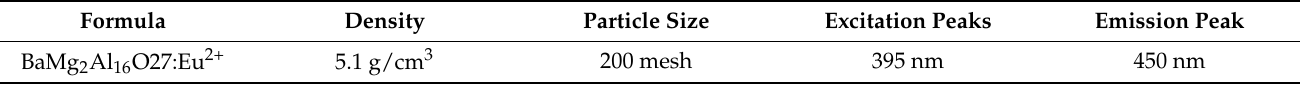
Table 2. Material properties of barium magnesium aluminate.